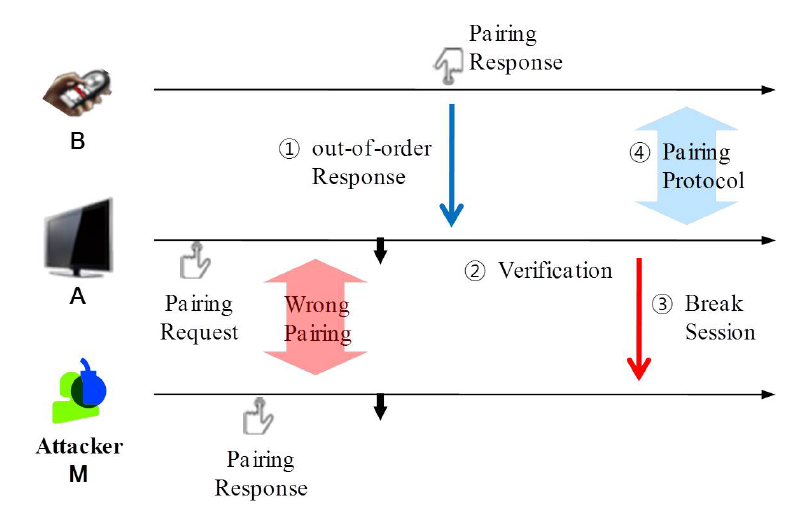
Figure 3. Key idea of the proposed